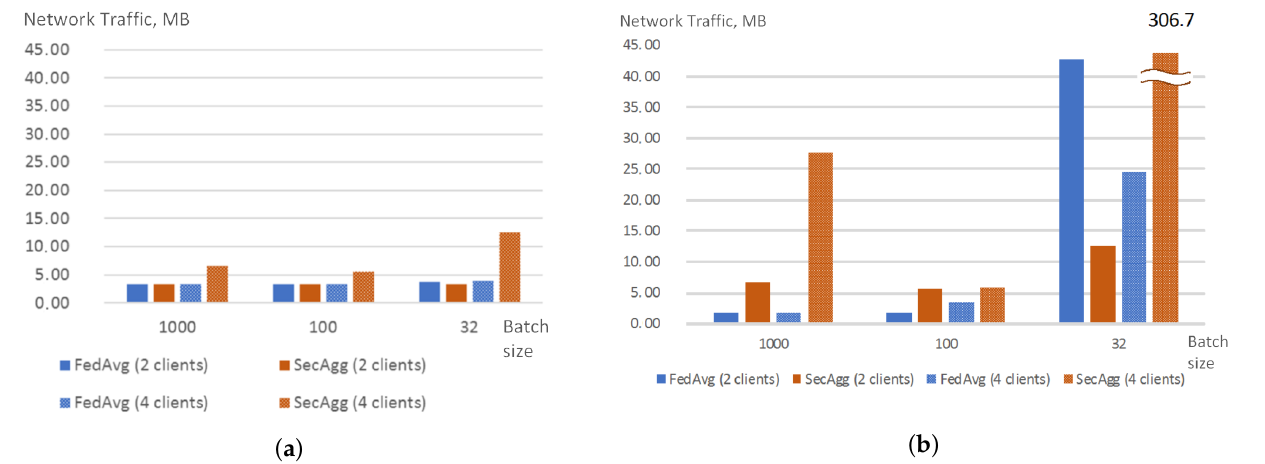
Figure 6. Network traffic (MB) generated by a client when training with FedAvg and SecAgg strategies for different experiment and model settings: 20 rounds ( a ), 10 rounds ( b